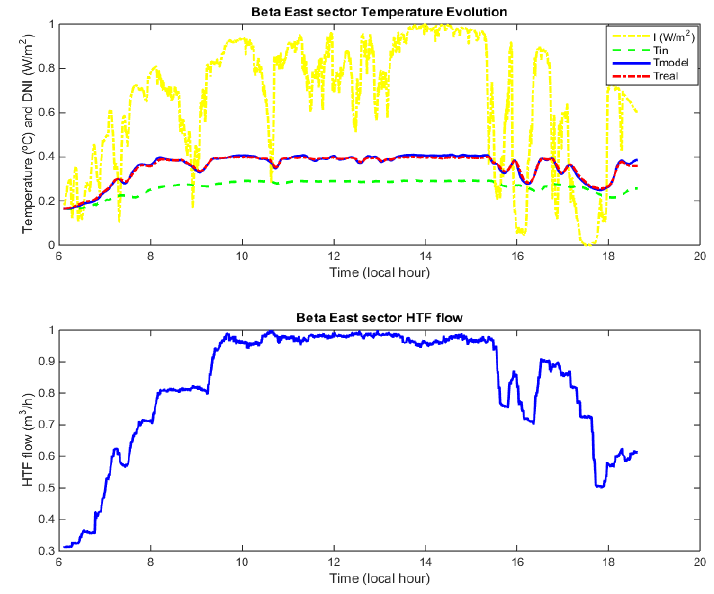
Figure 4. Beta East sector, model vs. real evolution: ( top ) model (blue solid) and real (red dash-dotted); and ( bottom ) HTF flow.